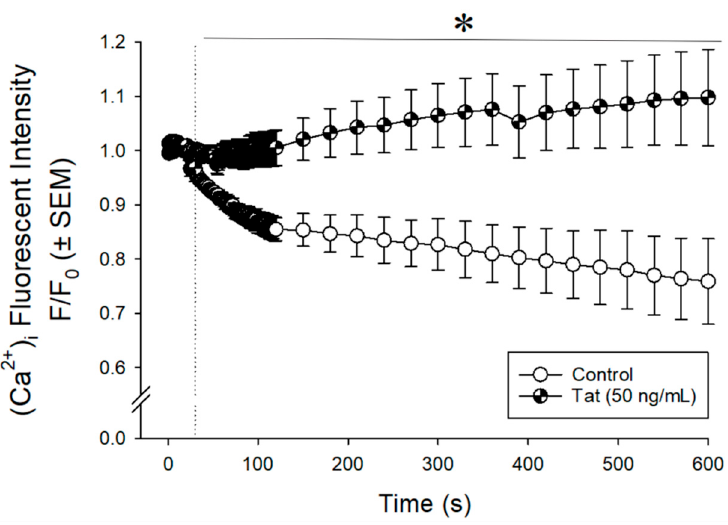
Figure 1. Intracellular Calcium Levels in Cultured Cardiomyocytes. Cells were incubated with Fluo-4 AM and intracellular calcium was measured over 10 min (every second for the first 2 min; and every 30 s for the next 8 min). Tat (50 ng/mL) or vehicle was applied at 30 s. * Indicates Tat-treated cells significantly differed from control at all times post 30 s; p ≤ 0.05, repeated measures two-way